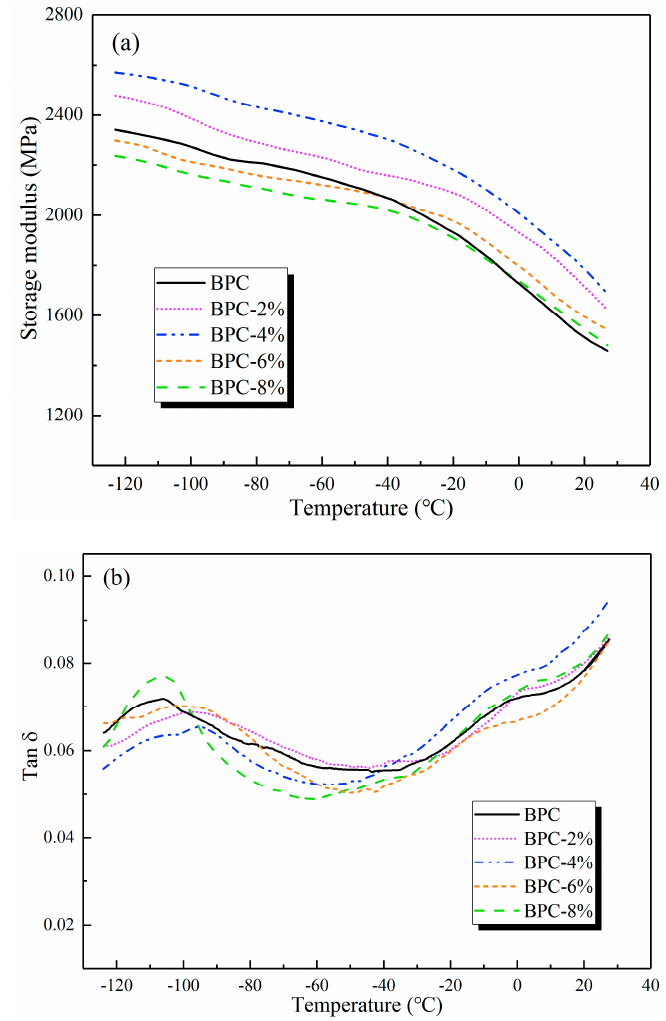
Figure 5. Plots of ( a ) storage modulus and ( b ) tan δ of the BPCs.